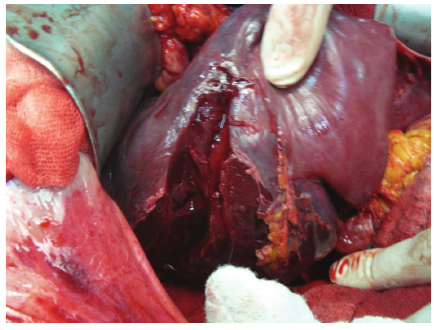
Figure 3: Bleeding lacerated liver at segments VI and